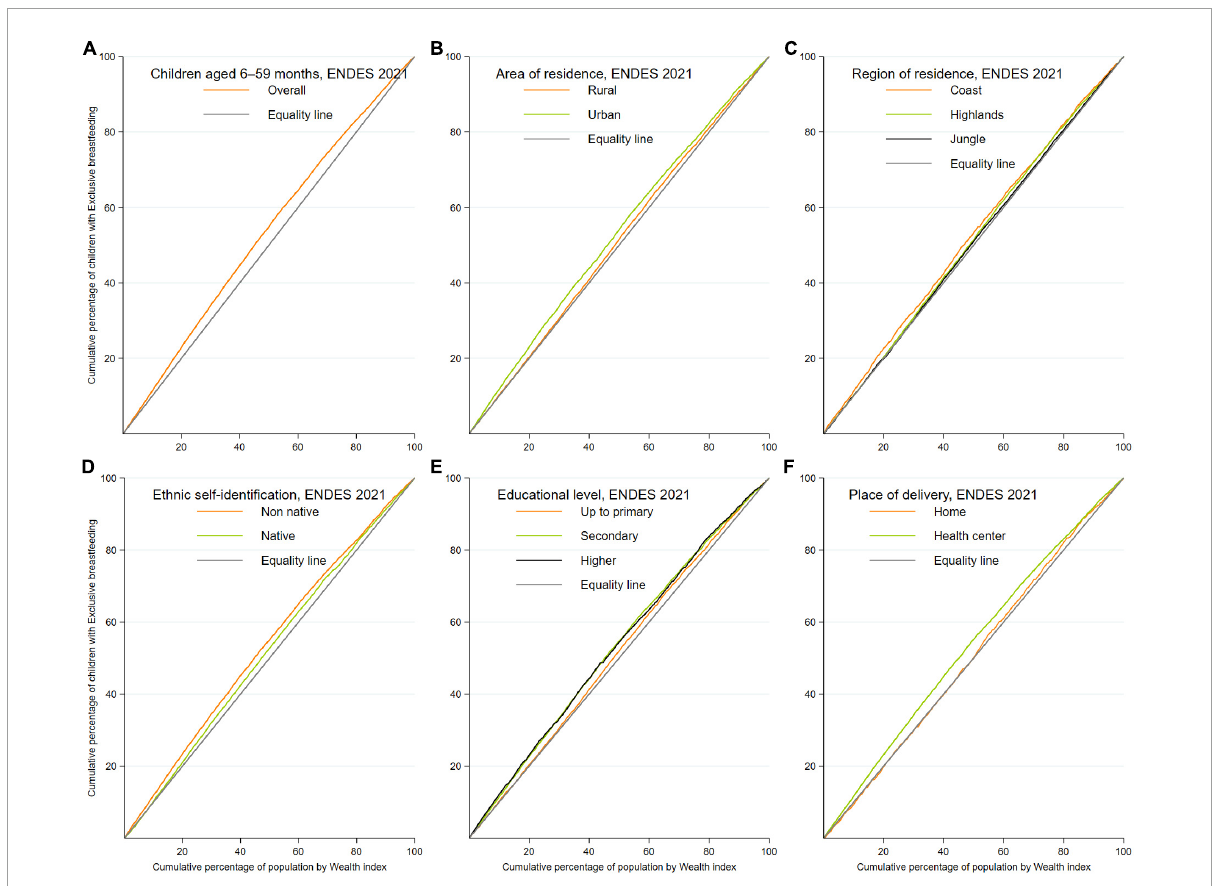
FIGURE2 Concentration curves (CC) of exclusive breastfeeding (EBF) among infants between 6 and 59 months of age. (A–F) Concentration curves according to the sociodemographic characteristics of the population